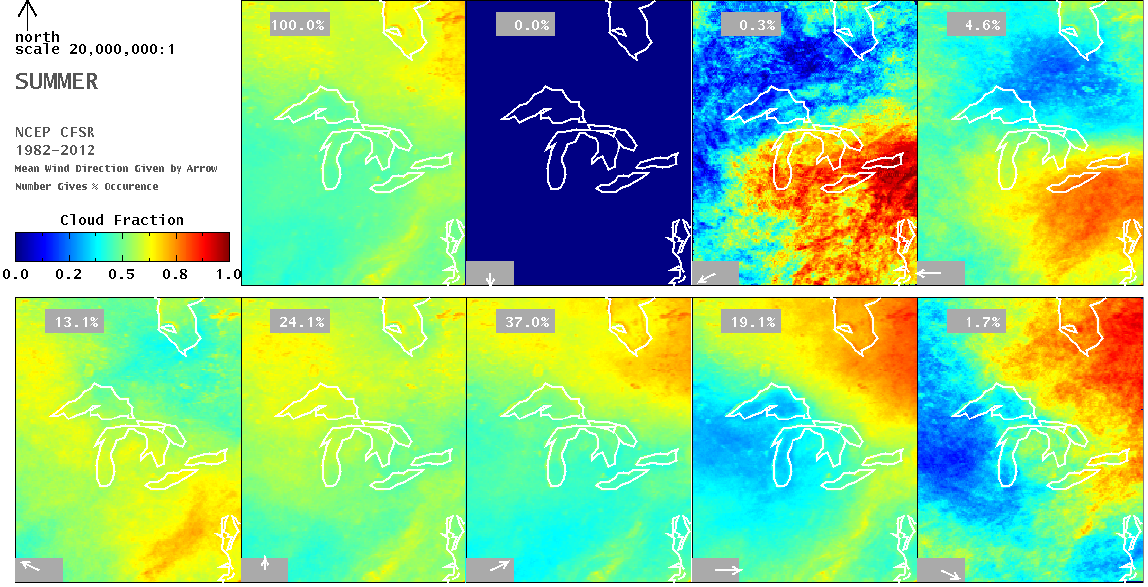
Figure 7. PATMOS-x cloud cover for the region during the 31-year time period during the summer months (June, July and August) composited with respect to wind direction. The wind direction is computed as the mean wind direction over a rectangle that covers all of the Great Lakes. The first panel represents the average summer cloud cover. The next panels represent the average cloud amount given the specified wind direction. The percentages of occurrences for a given wind condition are listed in the panel. There must be at least 10 occurrences to be compiled, so there are no northerly wind directions.